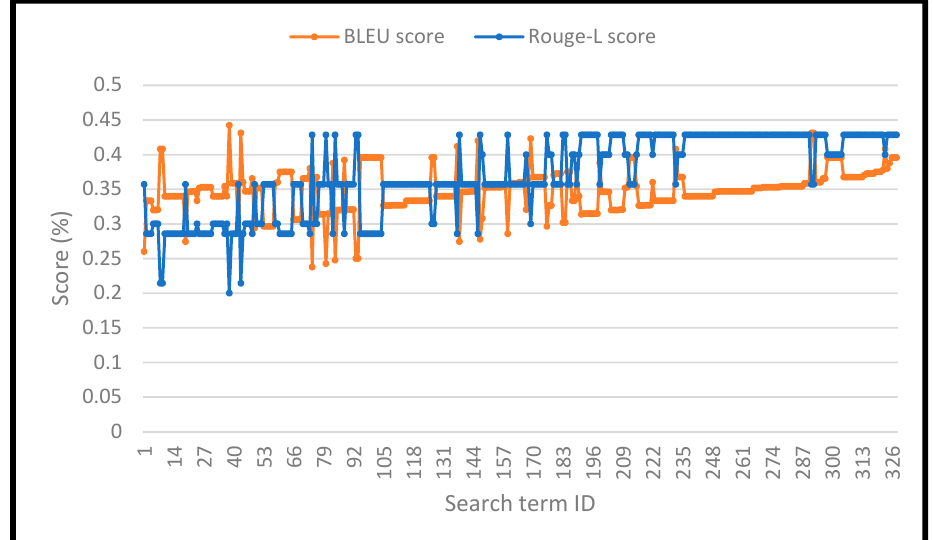
Figure 6. BLEU and Rouge-L scores for the search results. The figure represents the scores for the short search queries. The average BLEU score for the short search queries (on the horizontal axis) reached 37.2%, and the average Rouge-L score was 25.1%.